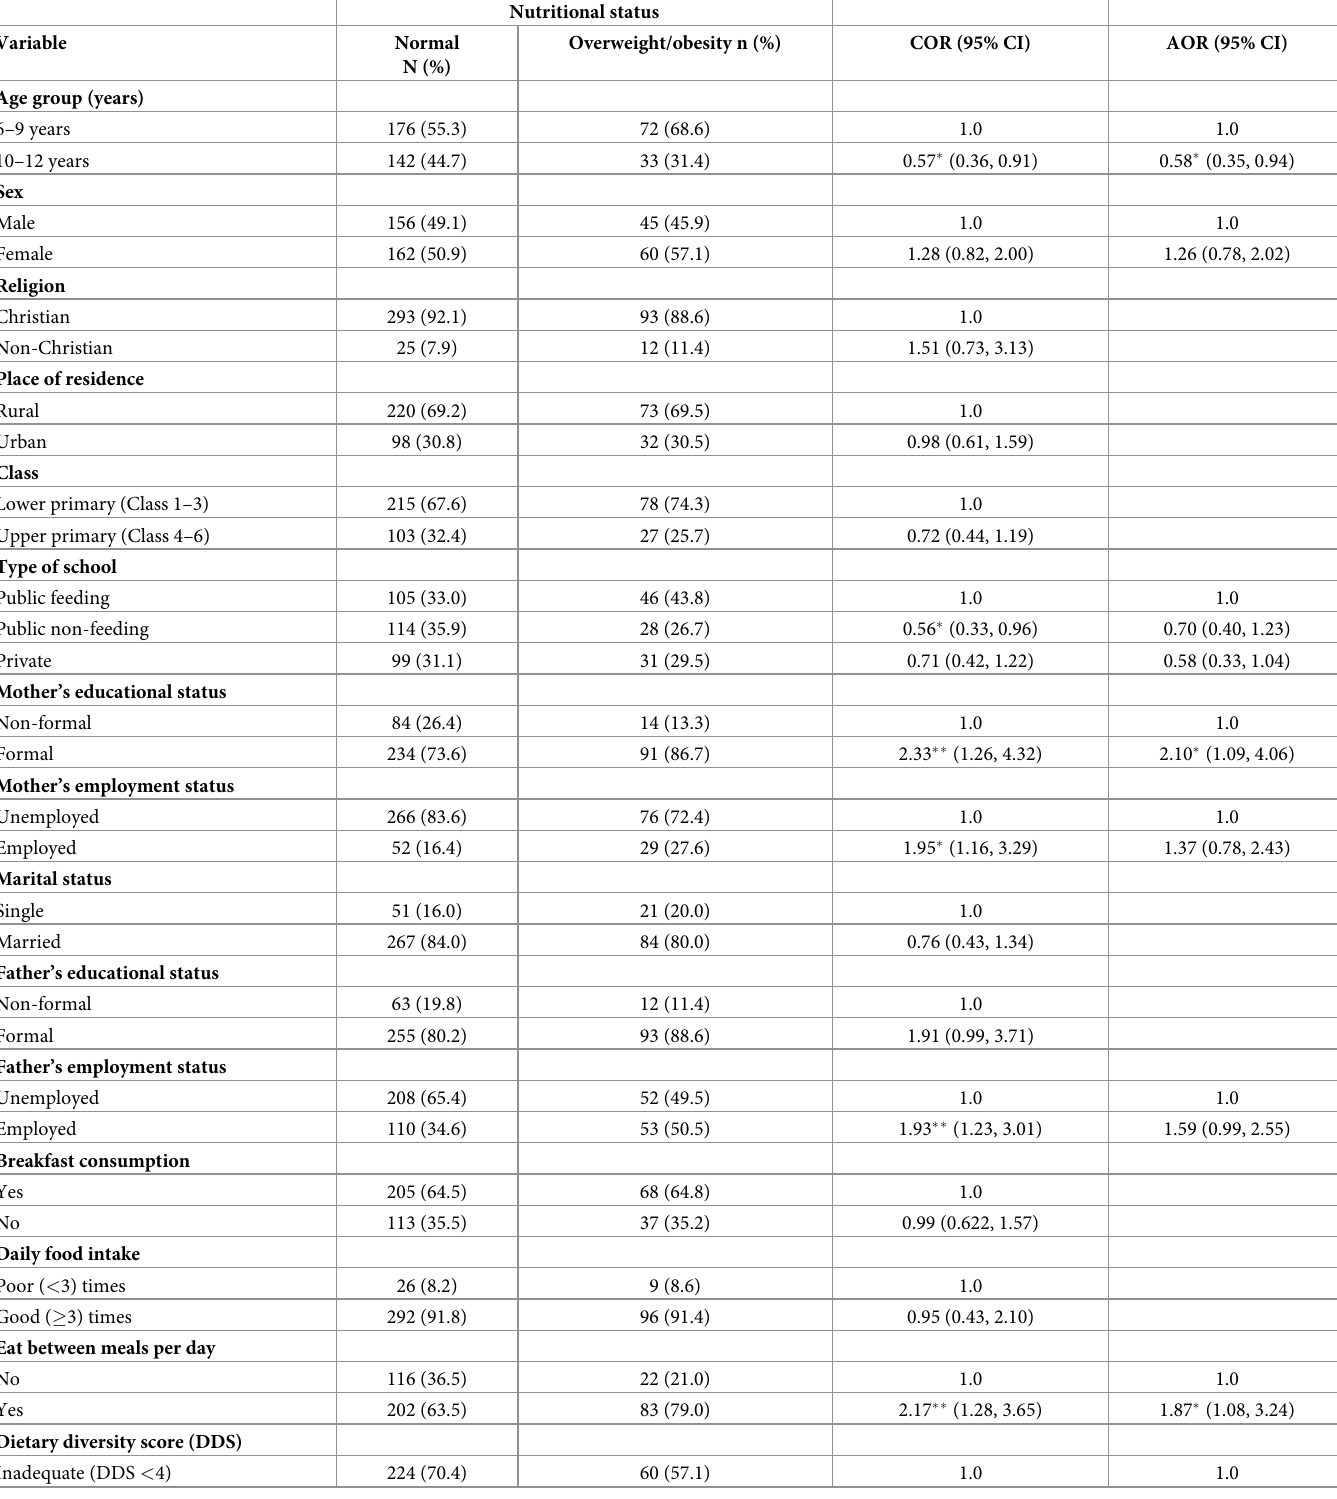
Table 3. Bivariate and multivariable regression analysis of factors associated with